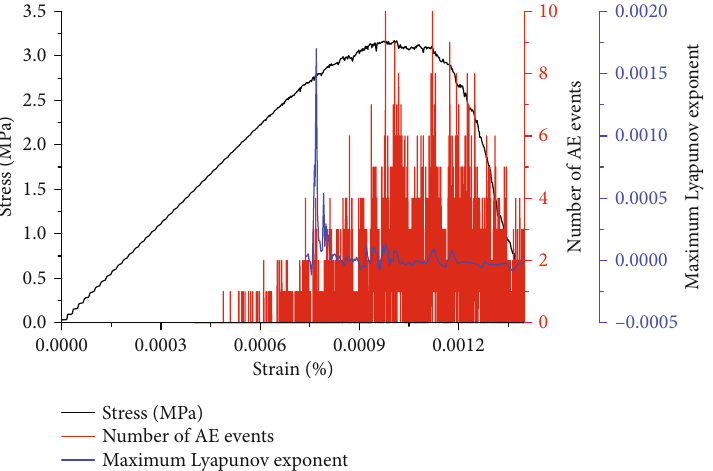
Figure 12: Stress-strain-number of AE events-maximum Lyapunov exponential variation diagram of specimen